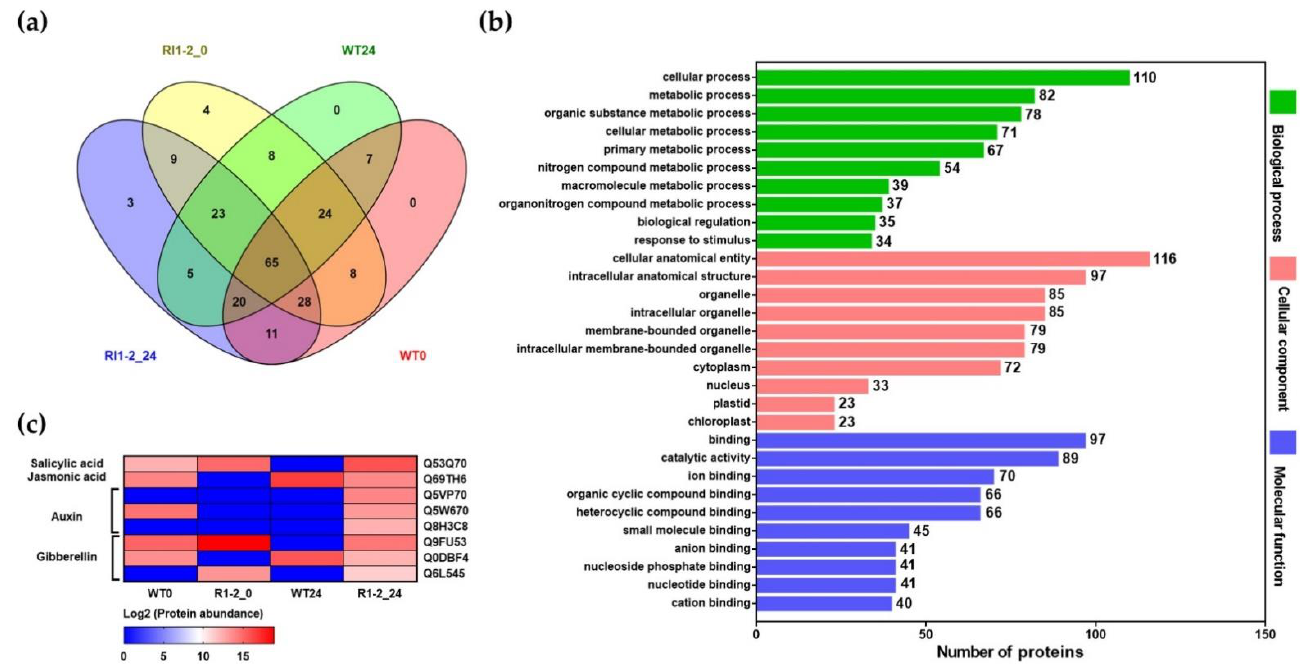
Figure 7. Proteome analysis in wild-type (WT) and OsVTC1-1 RI1-2 line at 0 and 24 hpi with rice blast 10100 isolate. ( a ) Venn diagram of differentially expressed proteins (DEPs) in WT and OsVTC1-1 RI1-2 line at 0 and 24 hpi; ( b ) gene ontology (GO) enrichment analysis of DEPs in the OsVTC1-1 RI1-2 line at 24 hpi in terms of biological process (green), cellular component (pink), and molecular function (blue); ( c ) heatmap of DEPs related to plant hormone synthesis and signaling pathways. Red color displays high expression levels of proteins and blue color represents low expression levels of proteins.